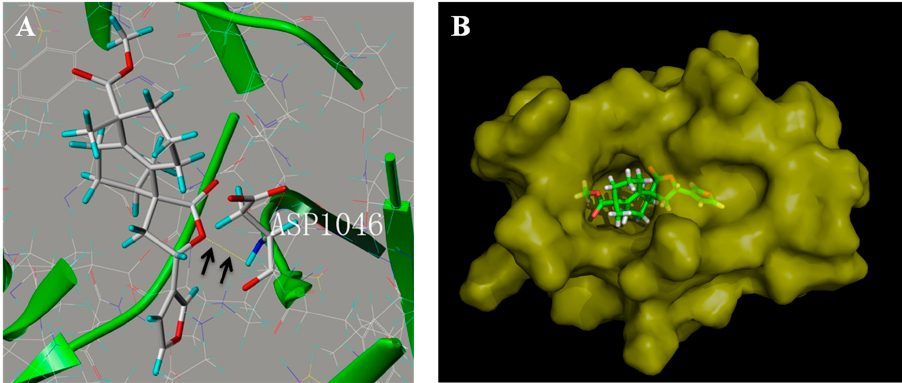
Figure 7. Penduliflaworosin interacted with the ATP-binding sites of VEGF receptor-2 kinase domain. ( A ) Penduliflaworosin formed hydrogen bonds with residue Asp1046; ( B ) MOLCAD surface modeling showed that the furan ring of penduliflaworosin extended into the deep cavity of the ATP-binding pocket of VEGF